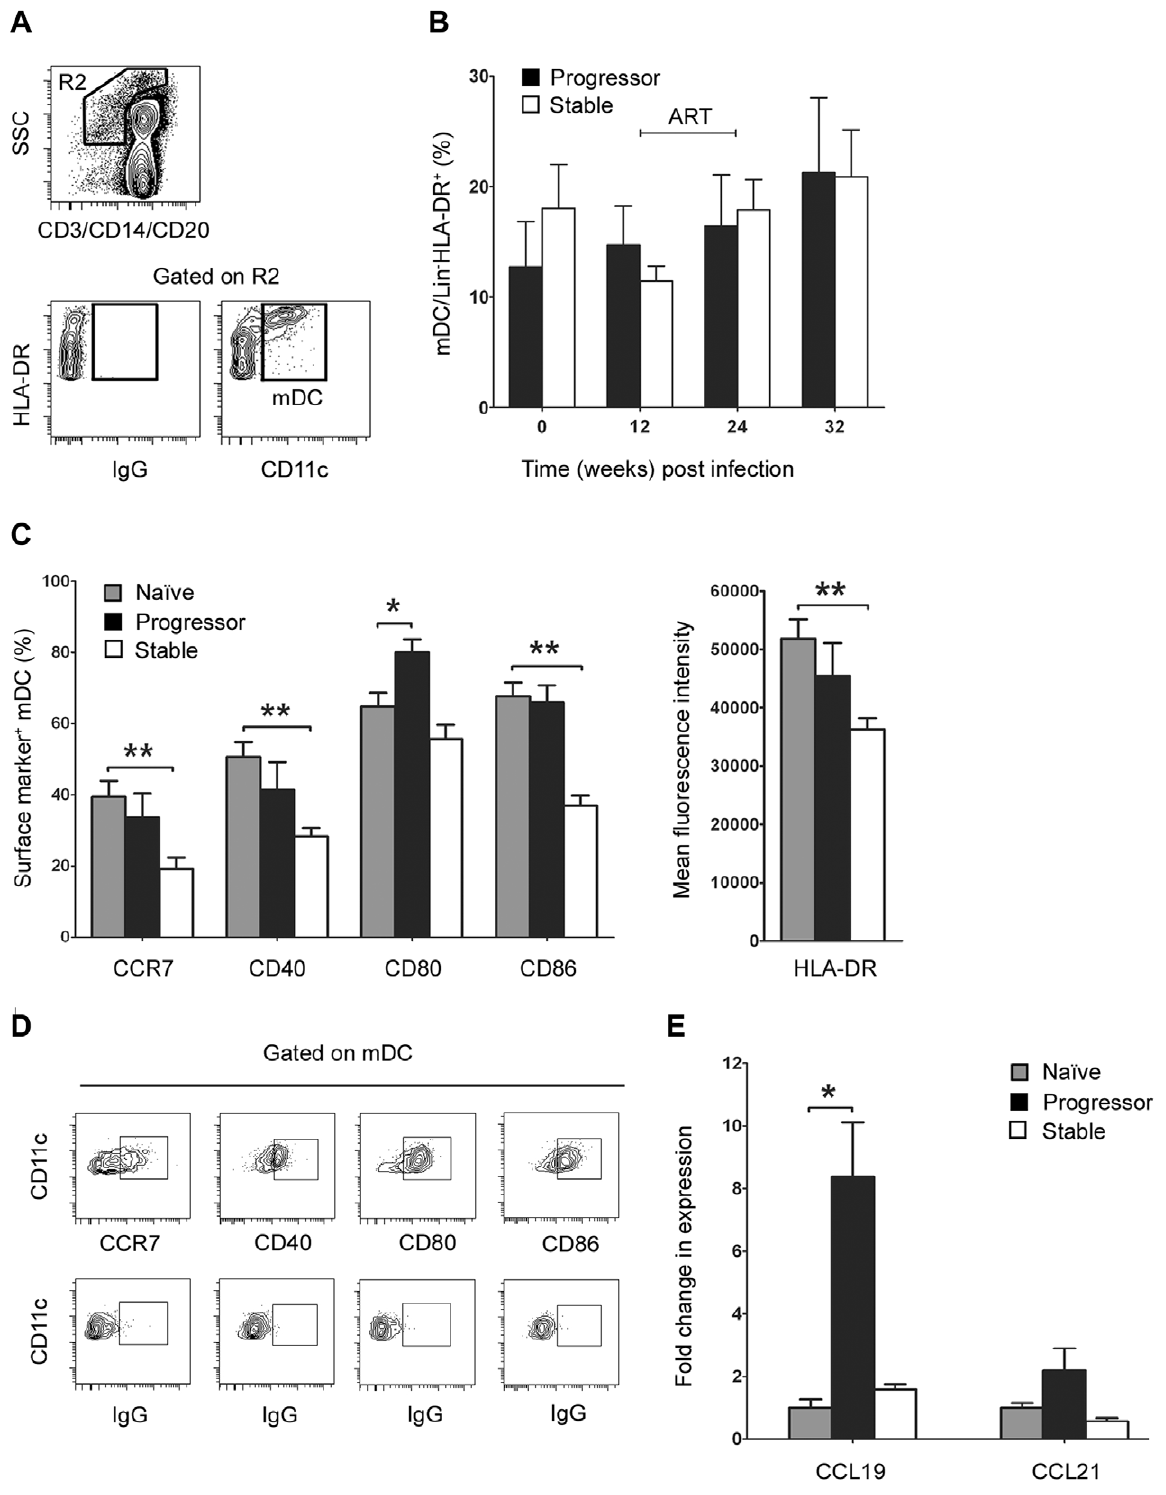
Figure 4. Differential mDC activation and tissue chemokine expression in lymph nodes correlates with disease progression. (A) Representative flow cytometry plots showing the gating strategy used to define CD11c + mDC within the Lineage 2 HLA-DR + fraction of peripheral lymph node cell suspensions. (B) The number of mDC in lymph nodes as a proportion of Lineage 2 HLA-DR + cells at intervals before and after SIV infection. Shown are mean 6 SEM for naı¨ve (T=0, n=18), progressor (n=7) and stable animals (n=10). (C) The proportion of lymph node mDC expressing CCR7, CD40, CD80 and CD86 relative to staining with a control antibody before and 12 weeks after SIV infection (left) and the mean fluorescence intensity of HLA-DR expression on lymph node mDC at week 12 post infection (right). Shown are mean 6 SEM for naı¨ve (n=8), progressor (n=6) and stable animals (n=6). (D) Representative flow cytometry plots showing gating strategy to identify positive cell populations. (E)